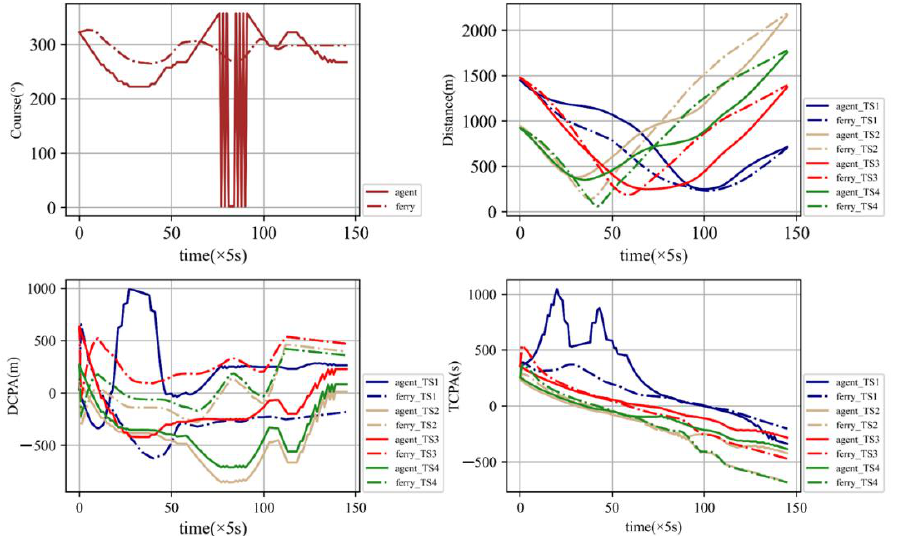
Figure 16. Course, relative distance, DCPA and TCPA.